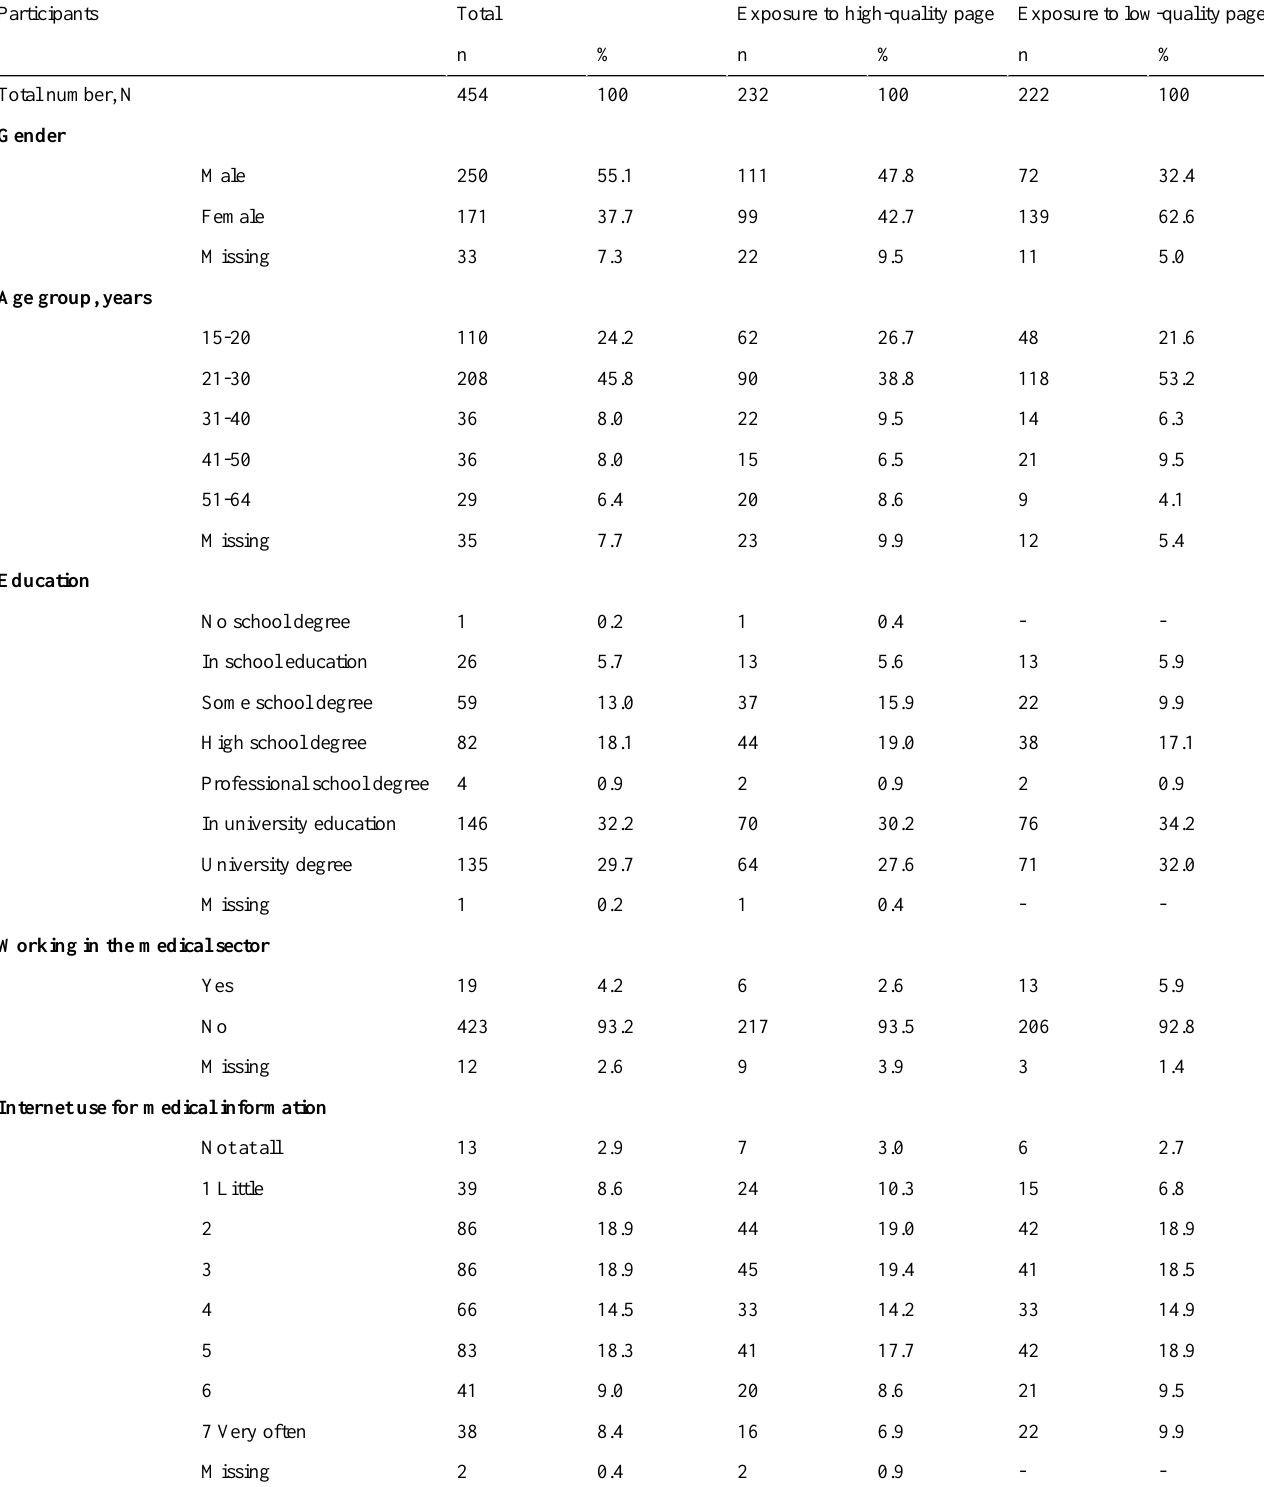
Table 3. Detailed sample description of the Internet survey.